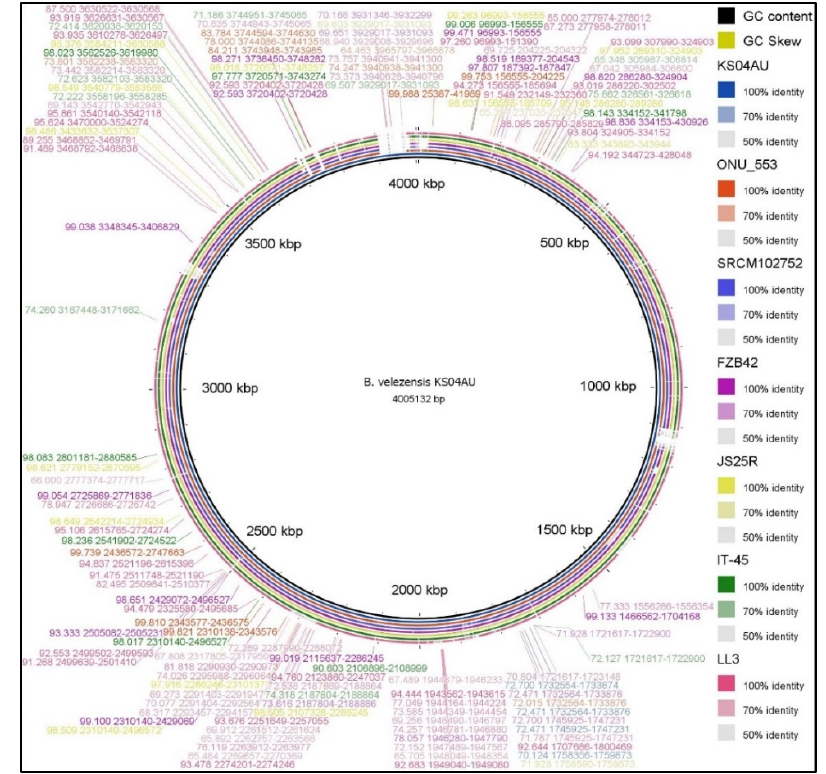
Figure 3. Blast Ring Image Generator (BRIG) plot showing a whole genome comparison. The figure shows BLAST comparisons of B. velezensis strains KS04AU, ONU-553, FZB42, JS25R, SRCM102752 and B. amyloliquefaciens strains LL3 and IT-45.